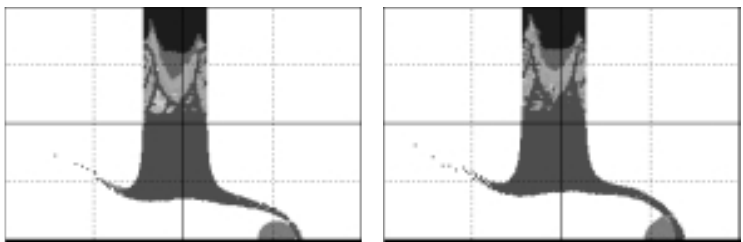
Fig. 12. Comparison of final state from comparable analyses with rigid fragment (left) and deformable fragment (right); in both analyses, m = 28.6 g, v = 1,370